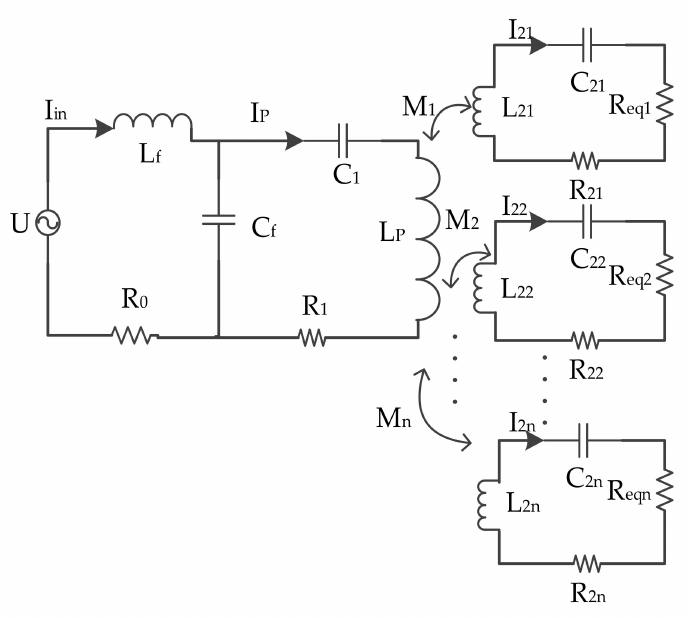
Figure 2. Equivalent circuit model of multiload inductive coupled power transfer (ICPT)